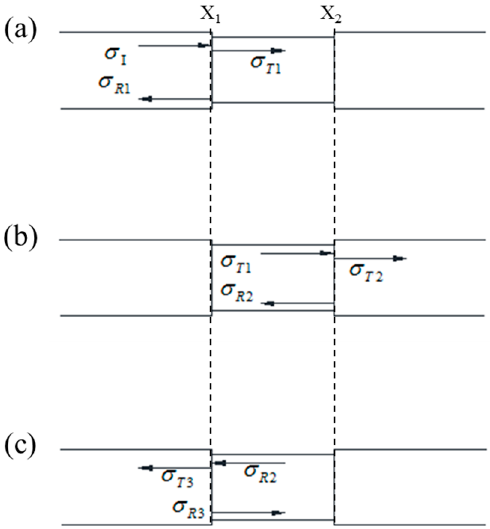
Figure 5. Reflection and transmission of elastic wave at specimen interface: ( a ) t < τ S , ( b ) τ S < t < 2 τ S , ( c ) 2 τ S < t < 3 τ S